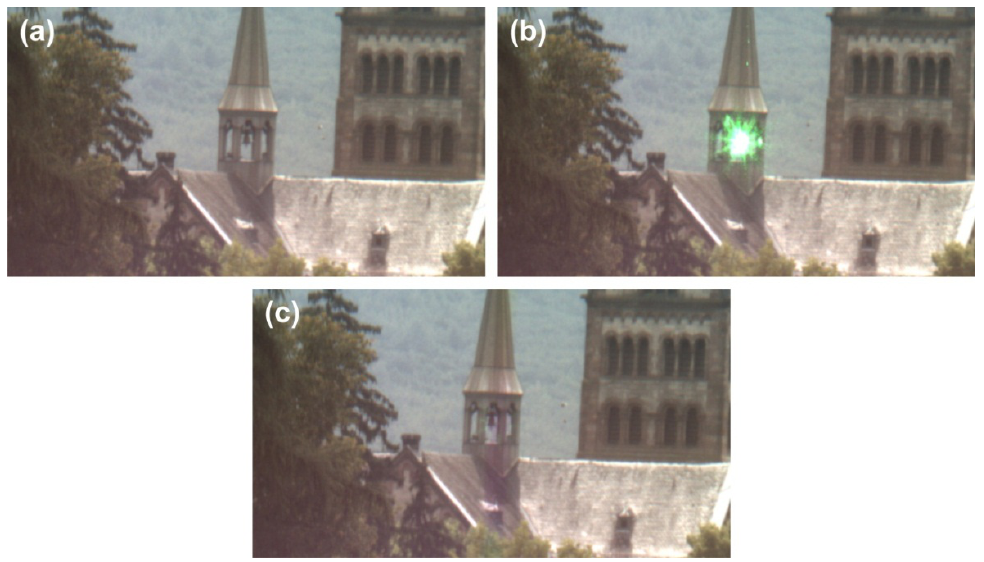
Figure 5. View of an urban scene imaged with an optical system as presented in Figure